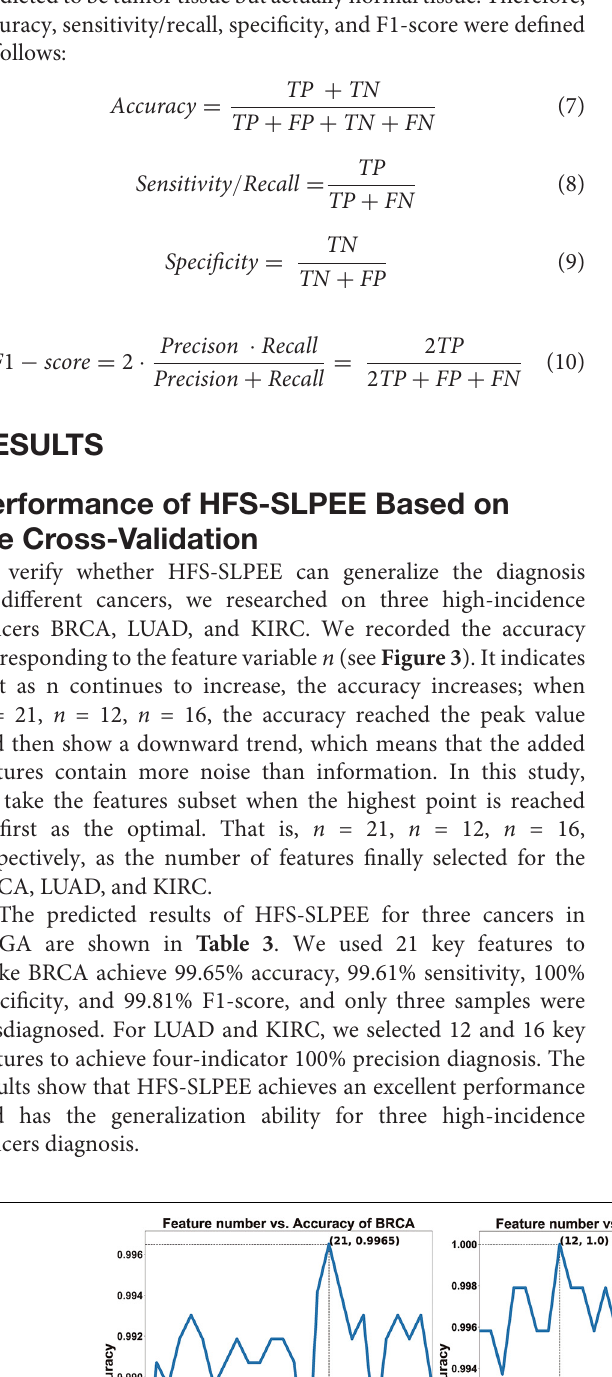
Frontiers in Cell and Developmental Biology |